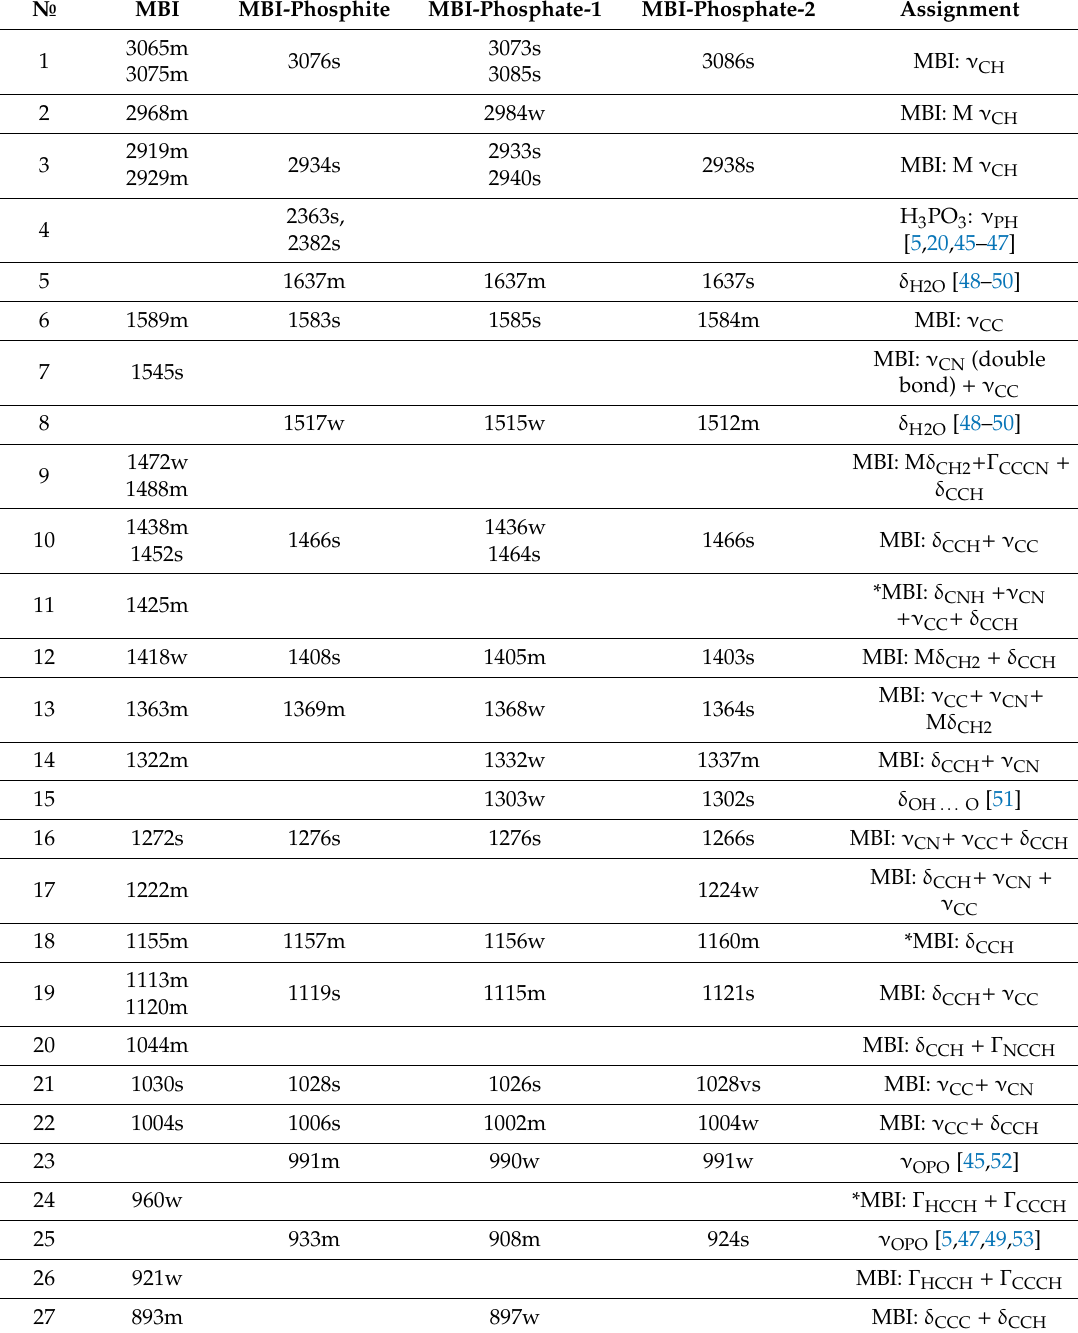
Table 2. Raman shifts in cm − 1 for lines observed in MBI, MBI-phosphite, MBI-phosphate-1,